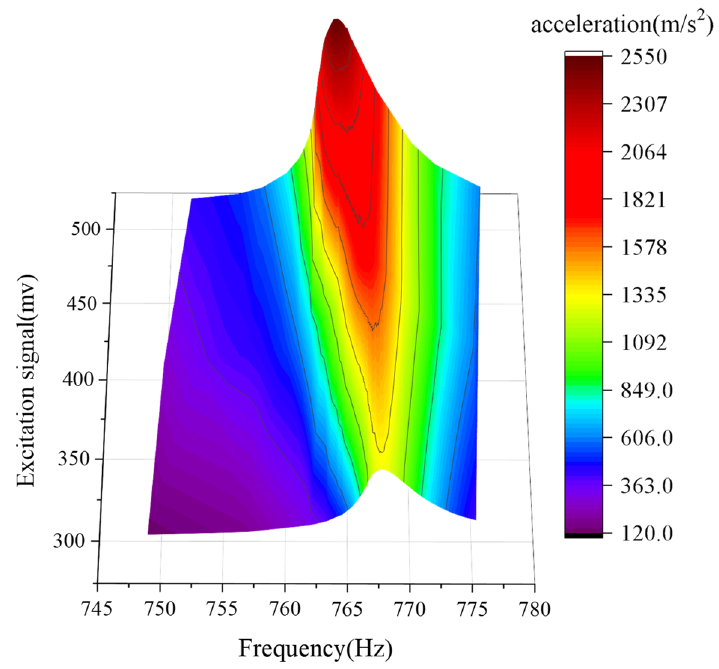
Figure 1. Schematic diagram of resonance peak shift.